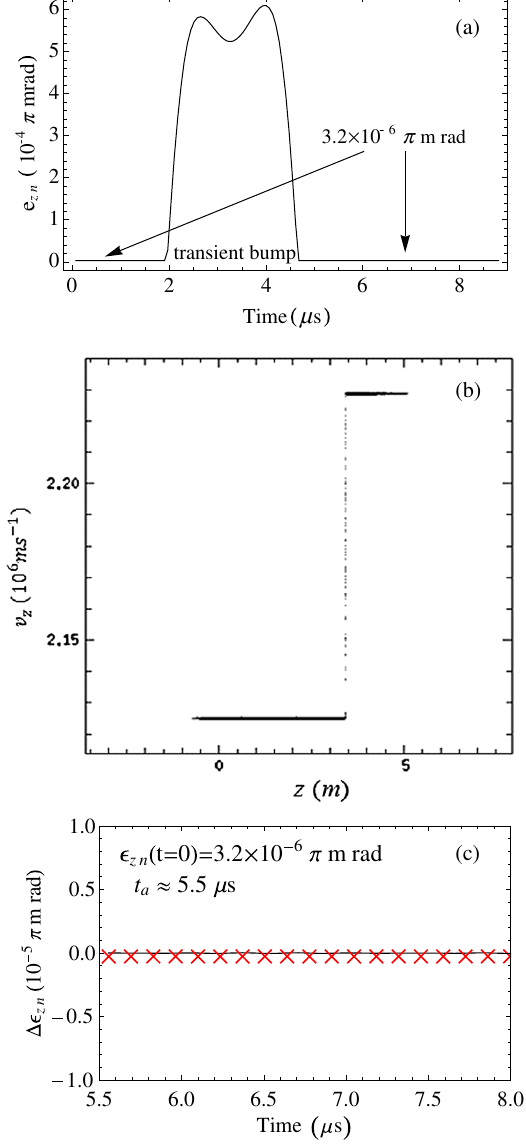
ð t Þ plot for the Rb beam accelerated by a gap FIG. 2. (a) (cid:1) zn (cid:1) z phase space with constant 0.2 MV flattop voltage. (b) v z configuration of the previous Rb beam in Fig. 2(a) to illustrate the big velocity difference when the beam is in transit through ð t Þ plot for the the gap. (c) The red crosses represent the (cid:1) (cid:1) zn compressed Rb beam with 10% velocity tilt. The black curve ð t Þ for previous beam in Fig. represents (cid:1) (cid:1) zn in Figs. 2(a) and 2(c) are the same as 3 : 2 (cid:3) 10 (cid:1) 6 (cid:7) m rad and the beam in Fig. 2(a) left the gap completely after time ¼ 3 (cid:6) s . We found that (cid:1) (cid:1) ð t Þ remains nearly zero in t a zn both cases, meaning that the normalized longitudinal emit- tance of a compressed beam conserves. In general root- conserves over the axial compression of mean-square (cid:1) zn the ion beam pulse as long as the beam experiences linear forces.